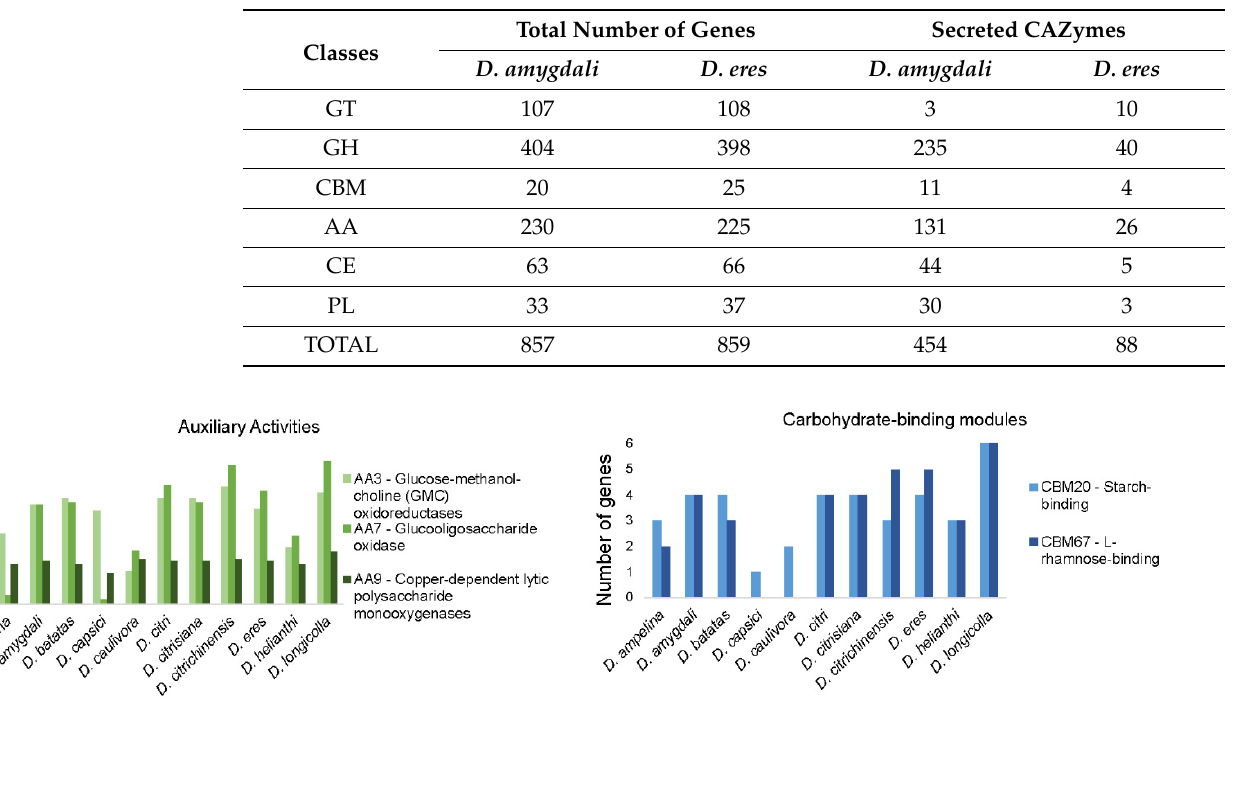
Table 6. Predicted genes encoding for CAZymes in the genomes of Diaporthe amygdali CAA958 and Diaporthe eres CBS 160.32.